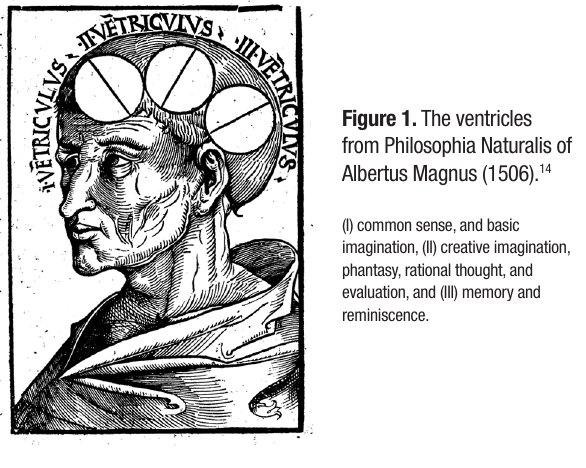
Figure 1. The ventricles from Philosophia Naturalis of Albertus Magnus (1506). 14